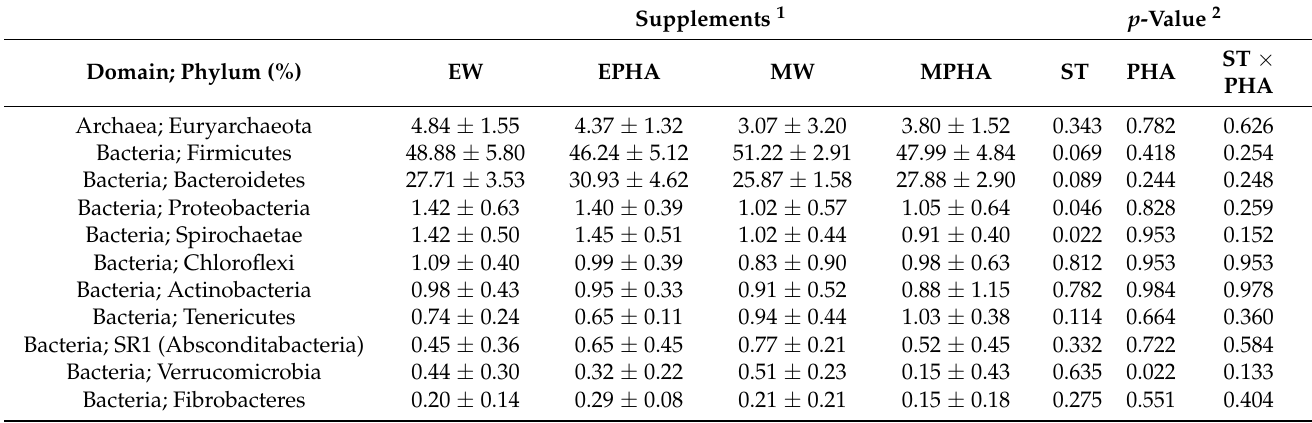
Table 5. Effect of phytogenic compounds in mineral or energy supplementation on the abundance of operational taxonomic units (OTUs) classified at phylum level of ruminal bacteria and Archaea domain (expressed as median ± interquartile range) of the in Nellore cattle grazing Urochloa brizantha cv. Marandu during the rainy